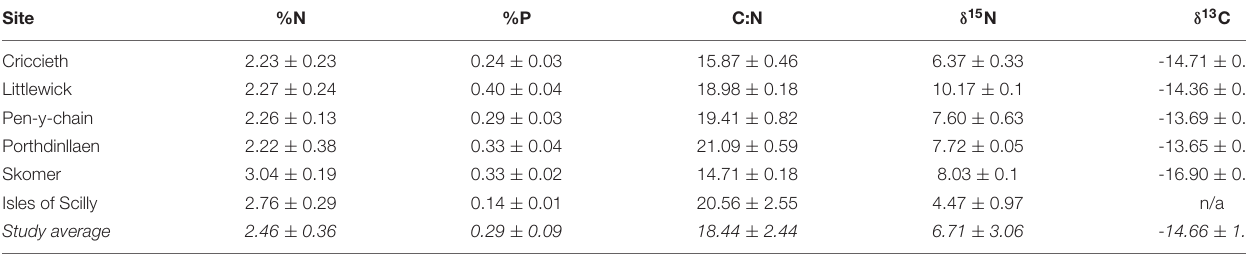
TABLE 1 | Results from the elemental analysis of Z. marina leaf tissue taken from the study sites.